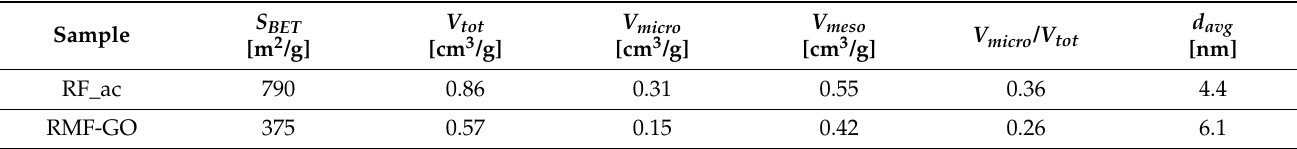
Table 2. Data deduced from the low-temperature adsorption isotherms *.